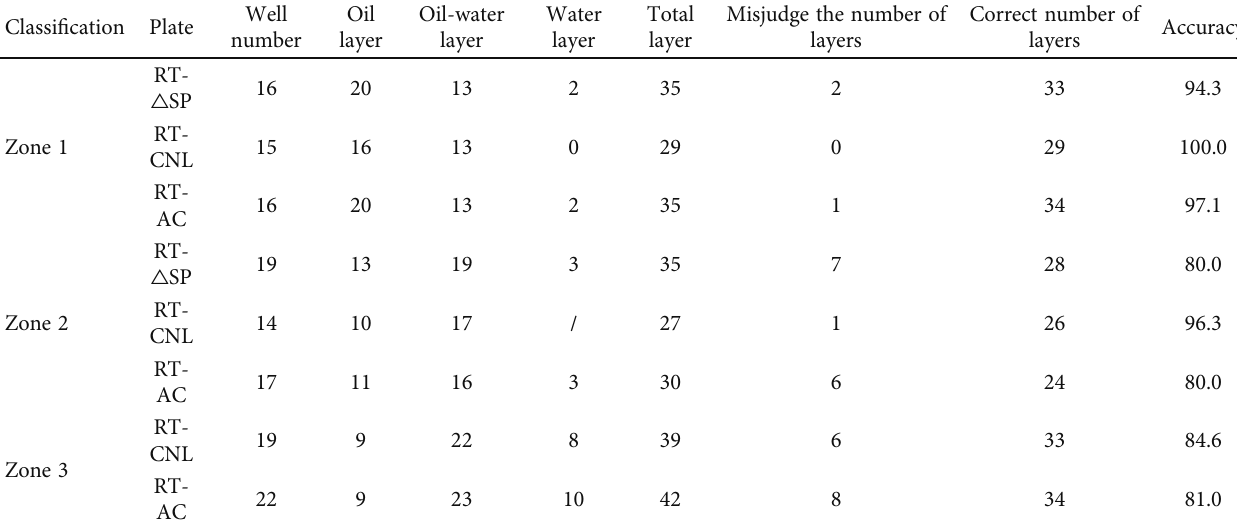
Table 10: Accuracy of identi fi cation chart of Putaohua oil